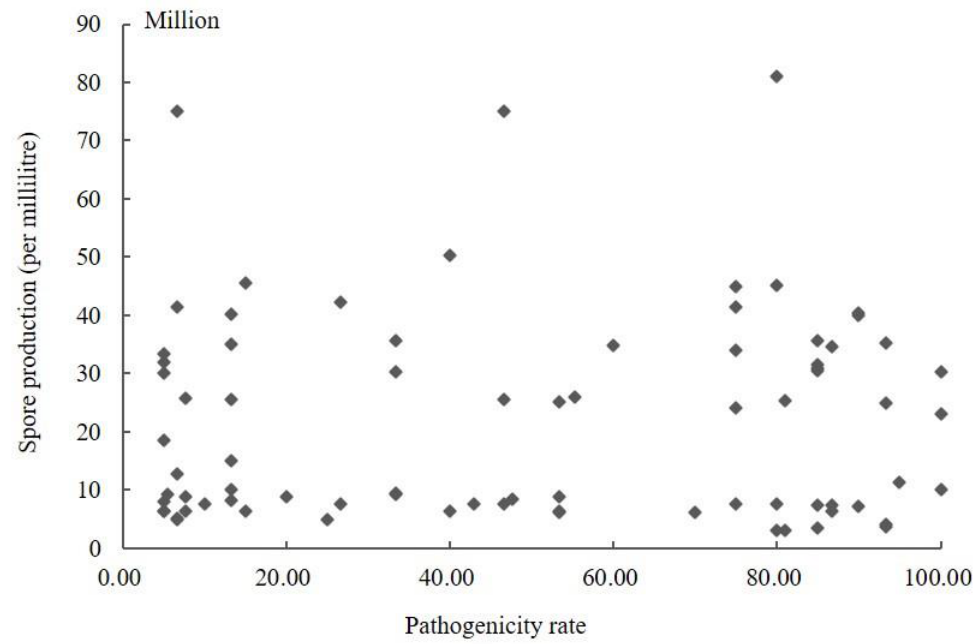
Figure 2. Scatter plot of sporulation quantity and pathogenicity of Ustilaginoidea virens .